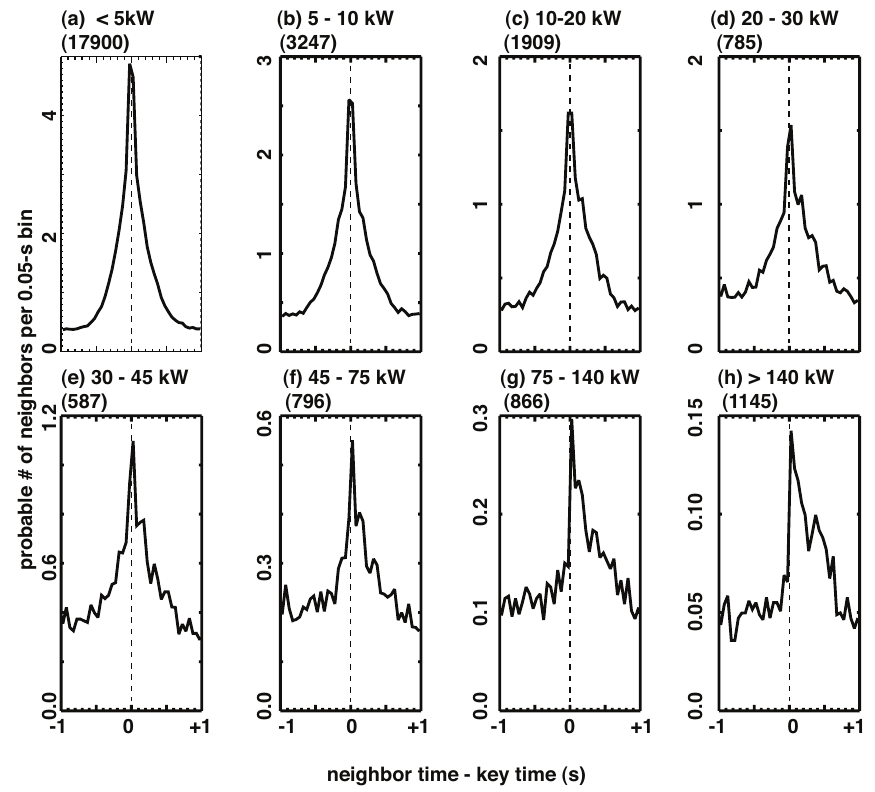
Fig. 13. Probability distribution of there being a FORTE VHF neighbor in bins of delay with respect to FORTE VHF key events coincident with any of the coincidence systems in Table 3. These key events are stratified by their ERP into eight ranges, from (a) ERP < 5kW, through (h) ERP > 140kW. The bin width is